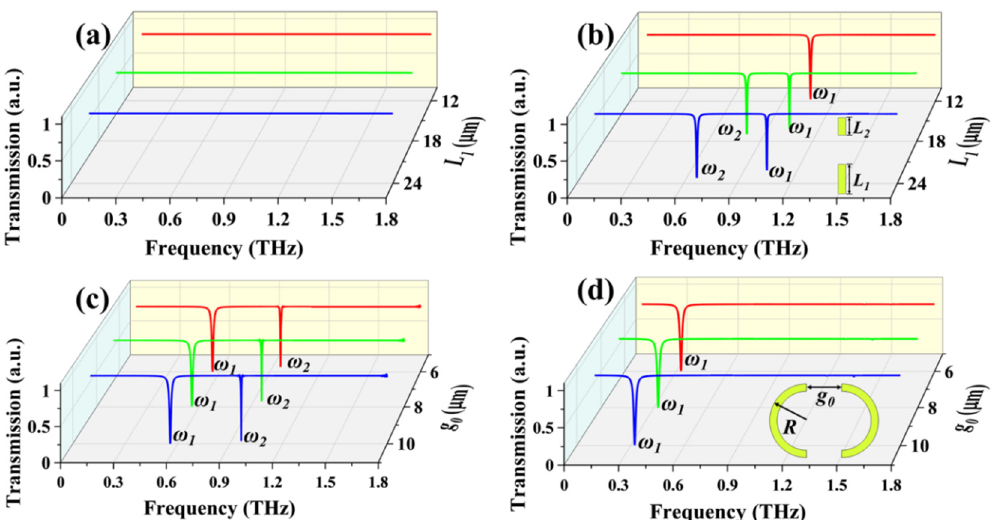
Figure 2. Transmission spectra of metal bars with different L 1 values in ( a ) TE mode and ( b ) transverse magnetic ™ mode and those of semicircle-shaped metamaterial with different g 0 values in ( c ) TE mode and ( d ) TM mode, respectively.